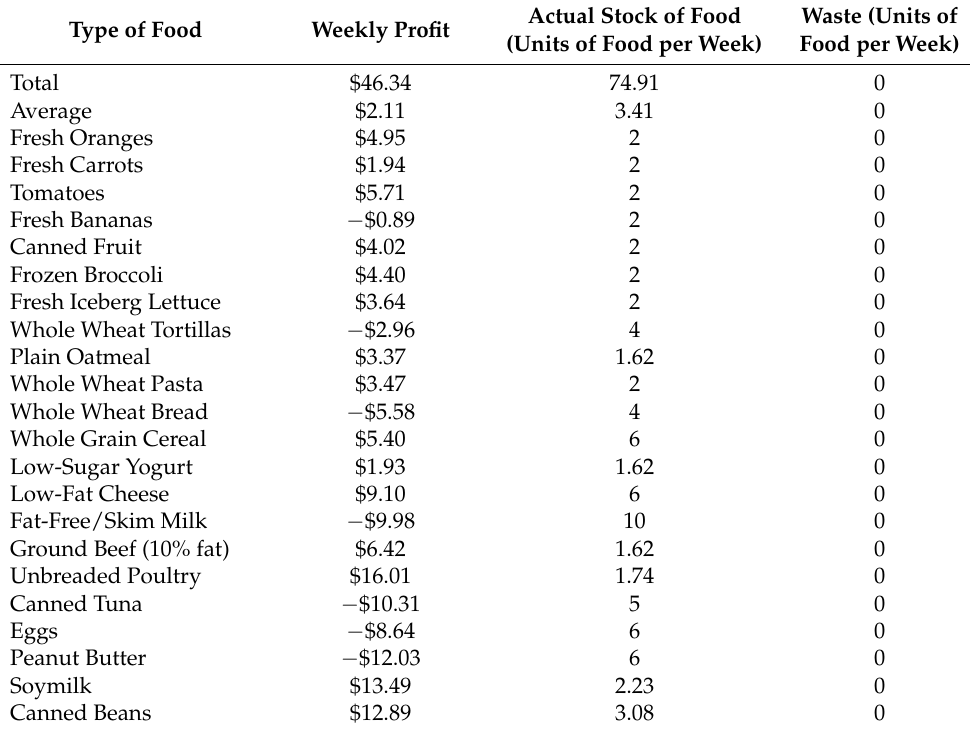
Table A4. Simulation Results for the WIC